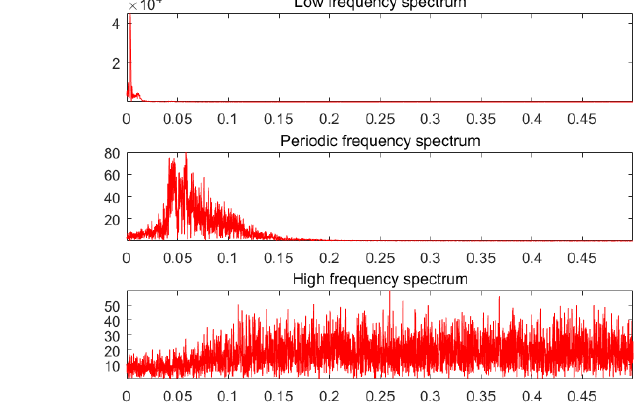
Figure 9. Reconstructed signal and spectrum for Line 3. The reconstructed signal and spectrum of different lines are analyzed. The low-frequency components of the fault line and the normal line change differently. The changing amplitude of the periodic frequency component of the faulty line is greater than that of the normal line at the beginning of the fault. The spectrum of the periodic fre- quency component of the faulty line is also different from the normal line. Based on the above, the analysis can determine line three for the fault signal.